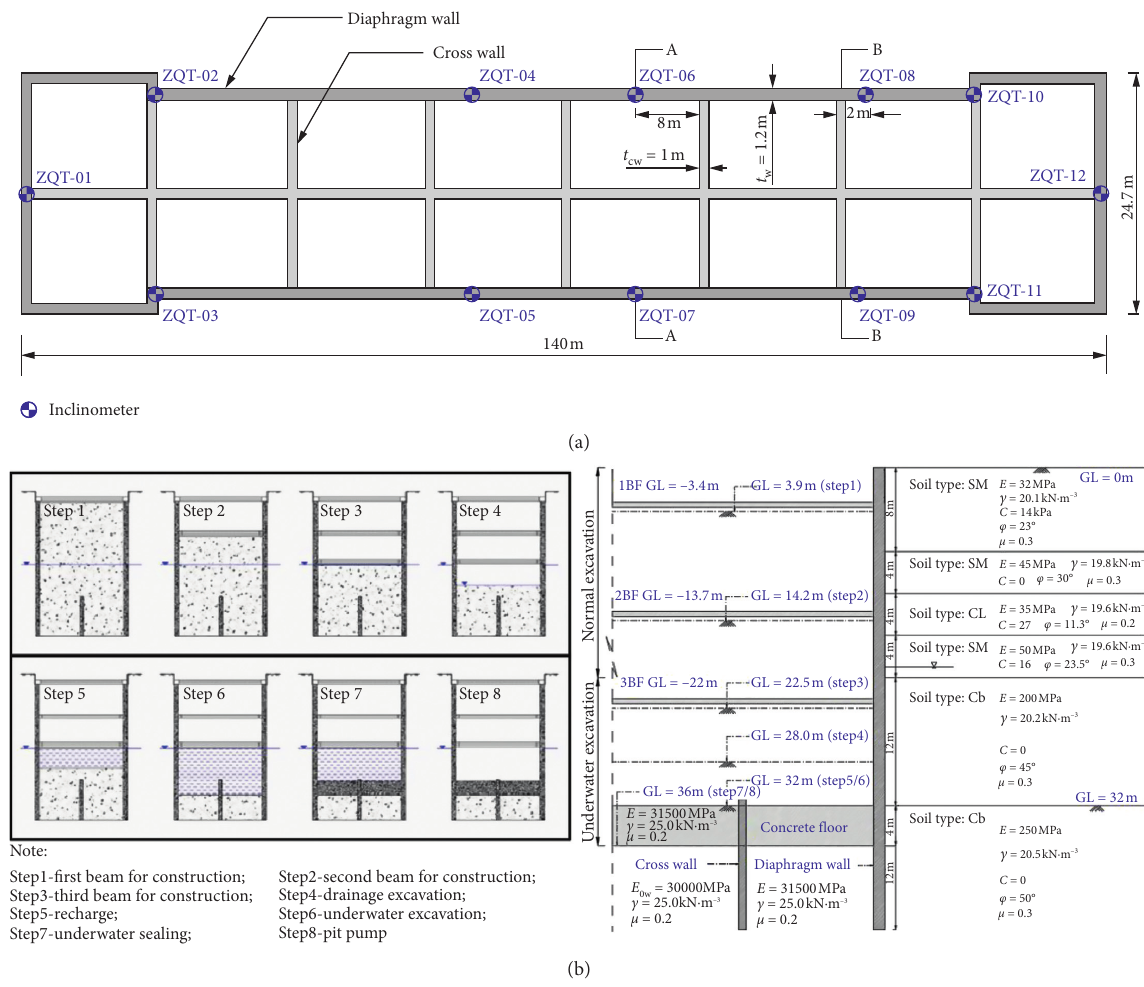
Figure 13: Excavation geometry and stratigraphy for YDM project. (a) Cross wall geometry and monitoring layout. (b) Excavation sequence and soil layer profiles.